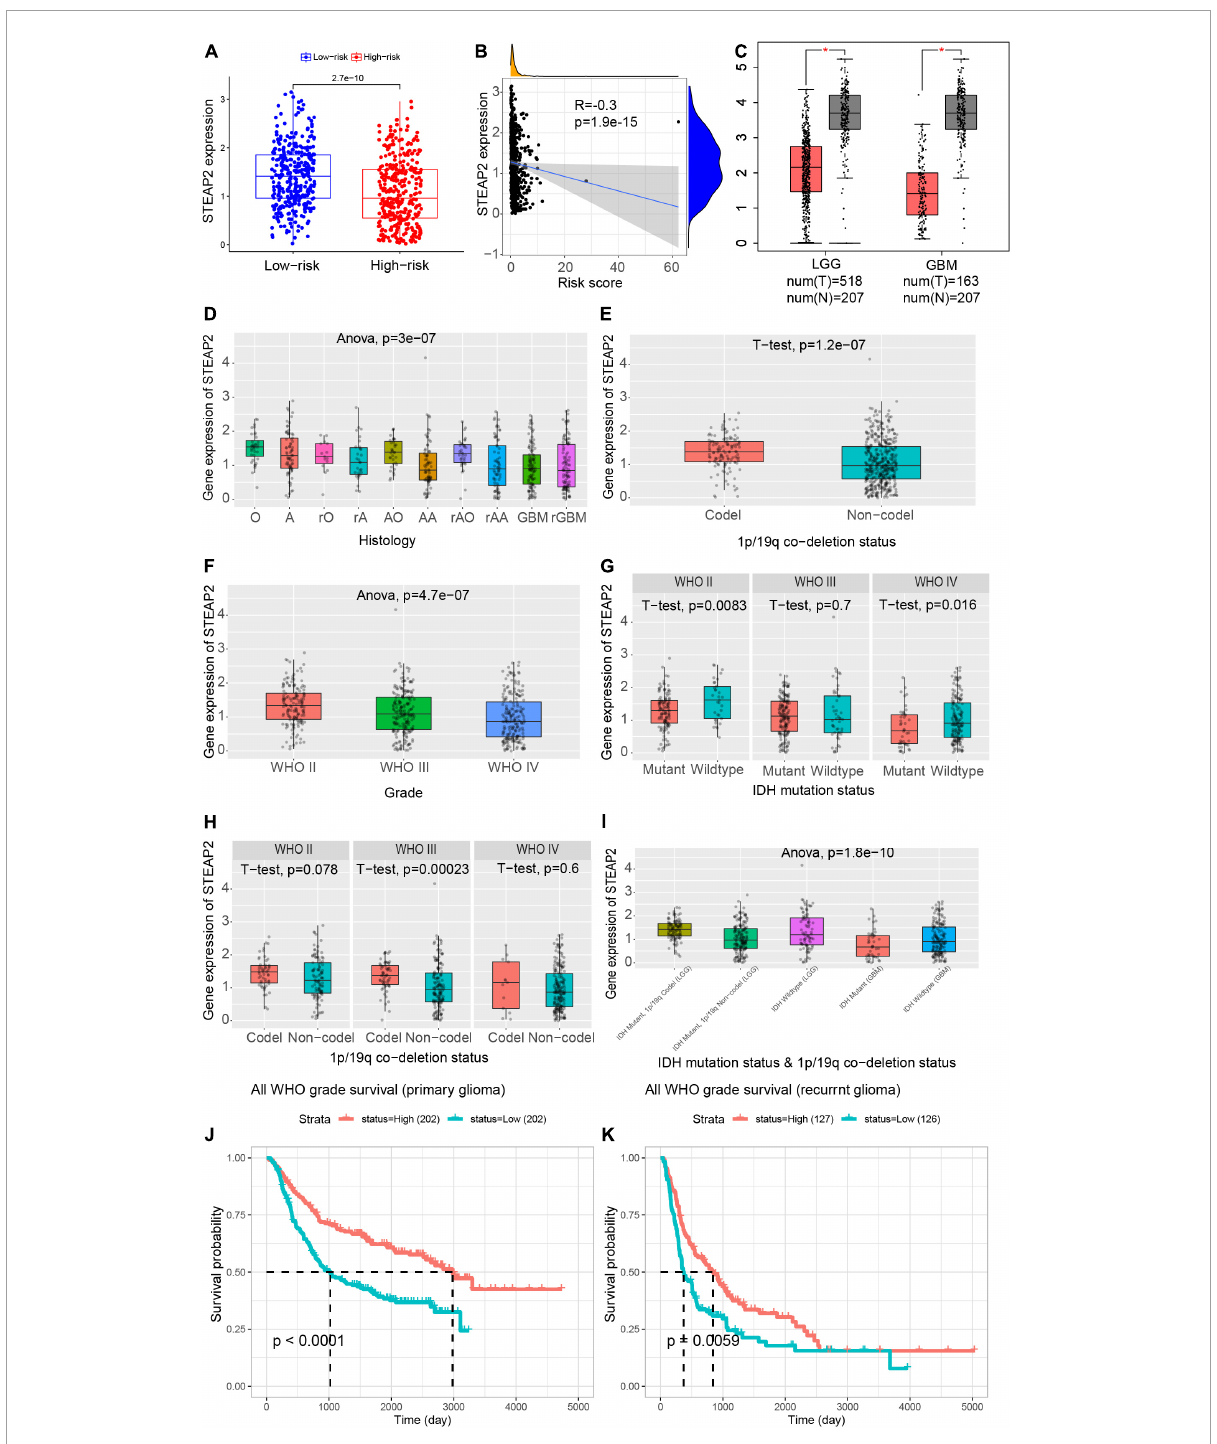
FIGURE4 Prognostic values of STEAP2 in variable grades of glioma. (A) Expression level of STEAP2 in the high-risk and low-risk groups. (B) Correlation analysis between the risk score and STEAP2 level. (C) Expression level of STEAP2 in normal and tumor tissues of LGG and GBM patients. (D) Expression level of STEAP2 in glioma with different histologies. (E) Expression level of STEAP2 in the 1p/19q codeletion and non-codeletion groups. (F) Expression level of STEAP2 in different WHO grades of glioma. (G) Expression level of STEAP2 in the IDH mutation and wild-type groups of different WHO grades of glioma. (H) Expression level of STEAP2 in the 1p/19q codeletion and non-codeletion groups of different WHO grades of glioma. (I) Expression level of STEAP2 in the different 1p/19q codeletion and IDH mutation groups of LGG and GBM. (J) Relationship between STEAP2 expression levels and overall survival in primary glioma according to the CGGA database. (K) Relationship between STEAP2 expression levels and overall survival in recurrent glioma according to the CGGA